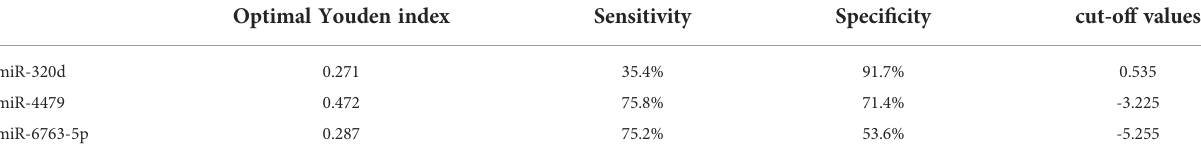
TABLE 4 Cut-off values of exosomal miR-320d, miR-4479, and miR-6763-5p between healthy donors and EOC patients.